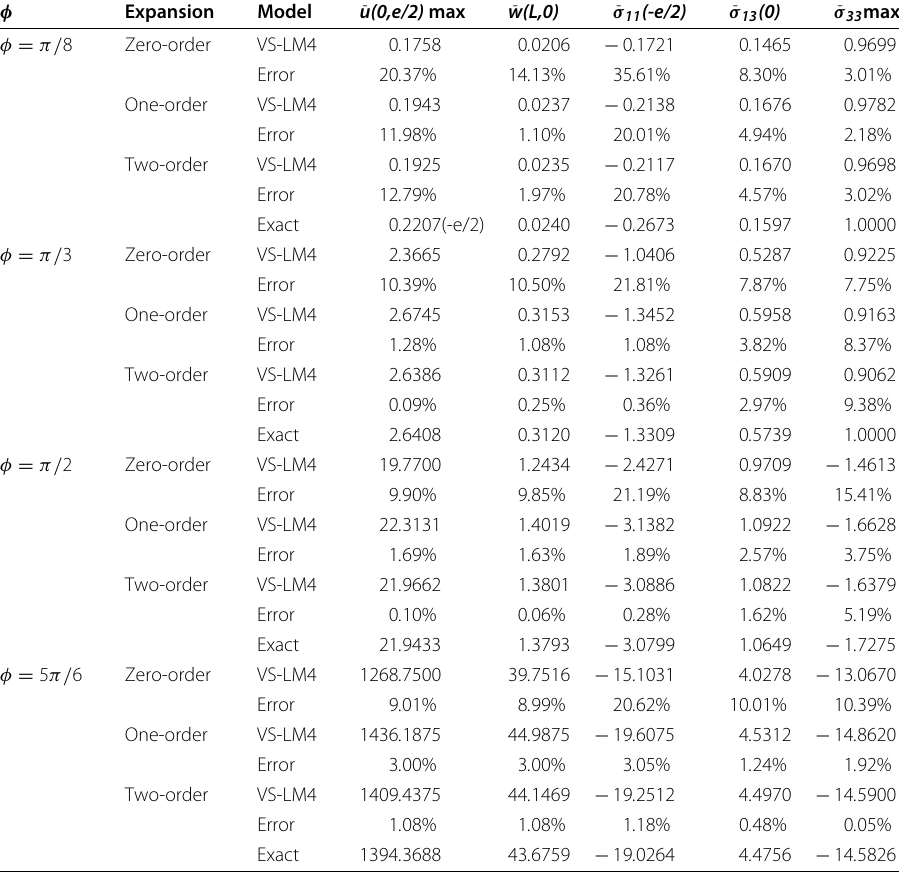
Table 3 Influence of the order-approximation of 1 /μ with respect to φ —one layer [0 ◦ ] — S = = 4 —mesh 26 × 10— N z